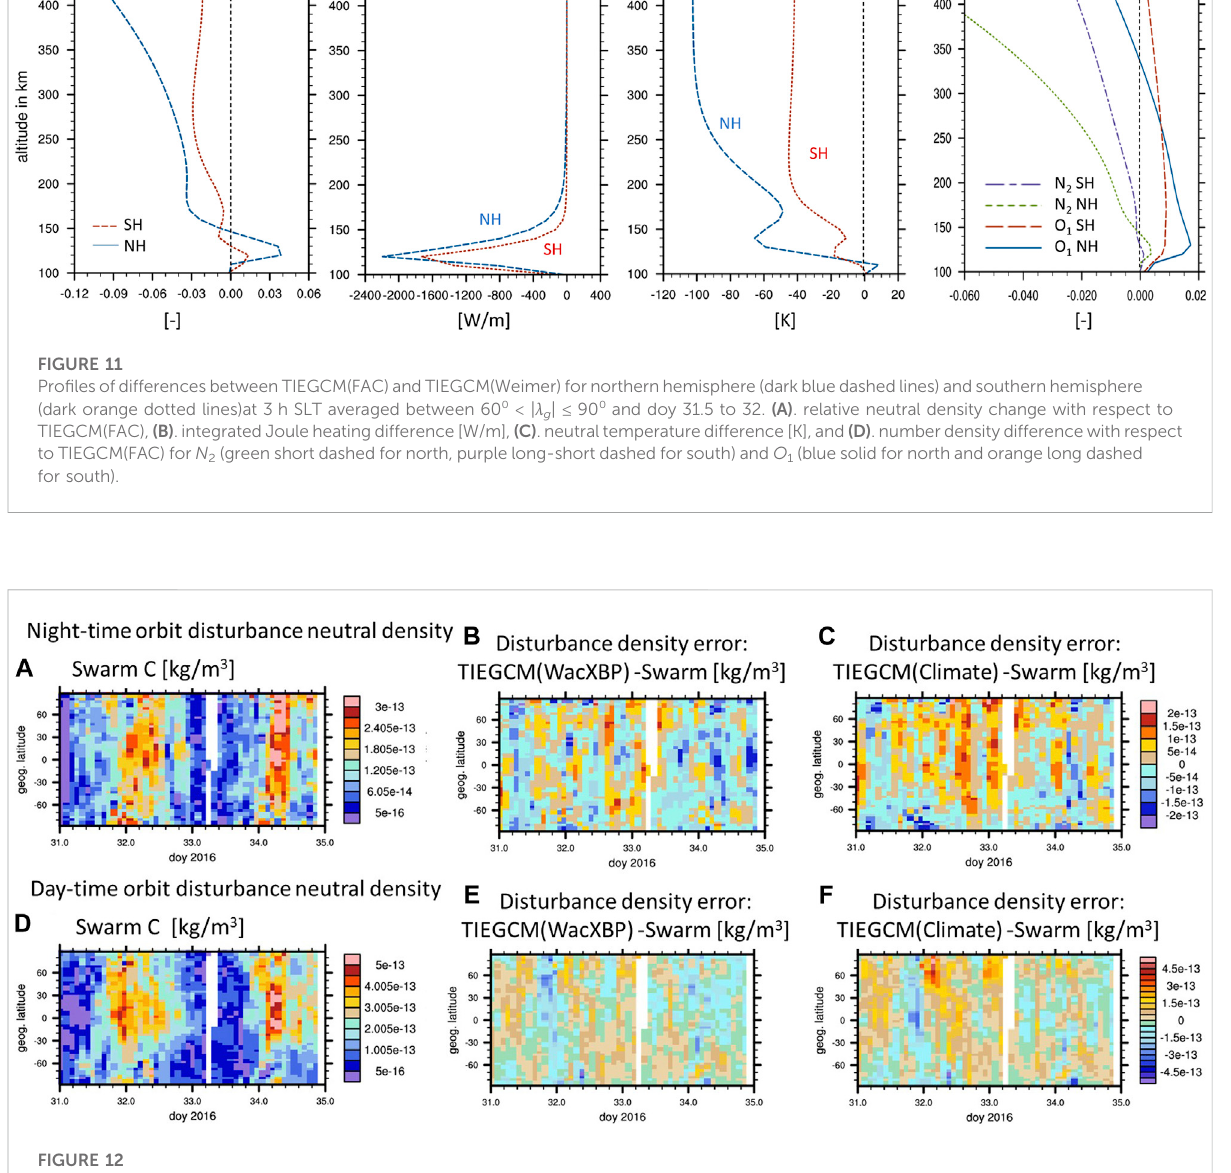
1 – 3% in the southern hemisphere compared to TIEGCM(FAC).